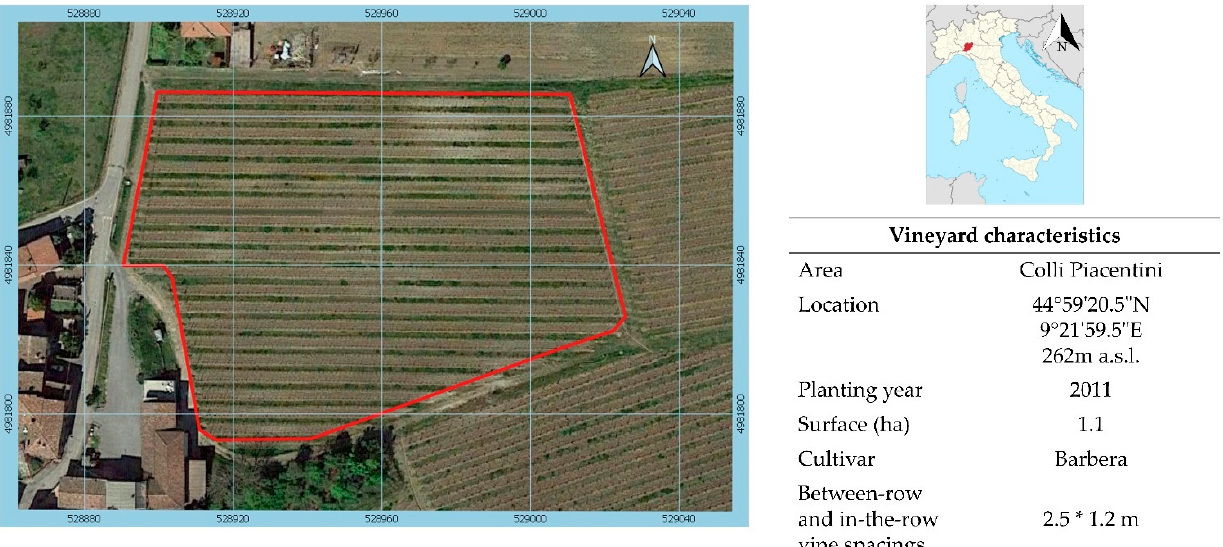
Figure 1. Characteristics of the vineyard under study.